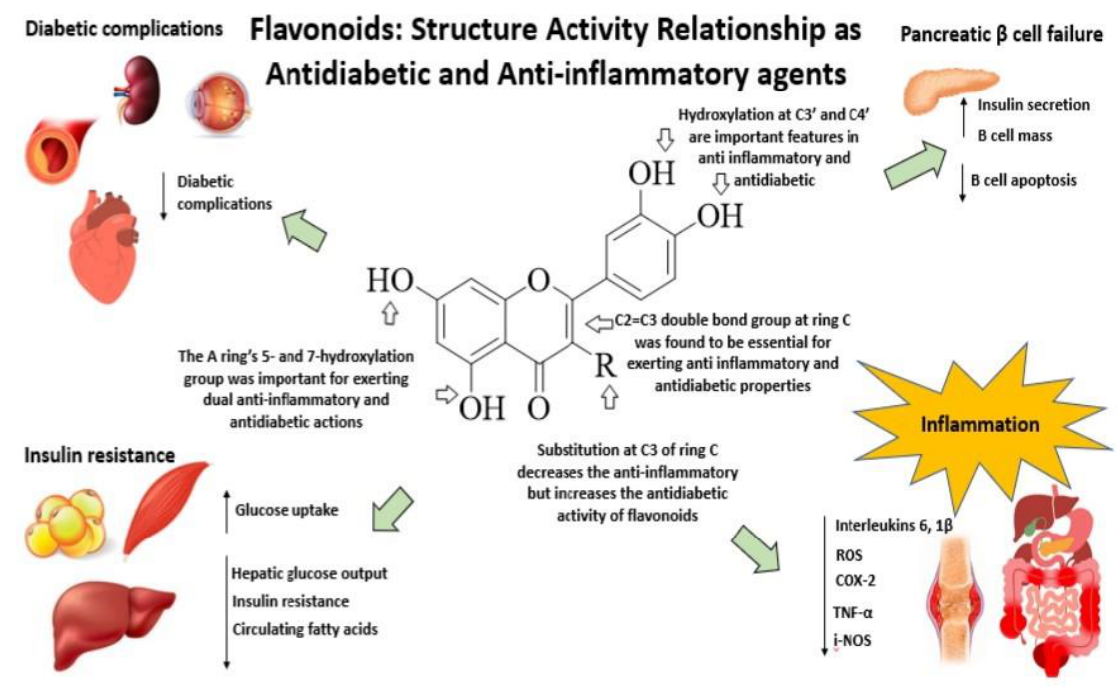
Figure 31. The SAR of flavonoids as dual action via anti-inflammatory and antidiabetic effects. Flavonoids have been reported to reduce diabetes complications, improve insulin secretion and pancreatic β cell mass, reduce β cell apoptosis, hepatic glucose output, insulin resistance , and circulating fatty acids, and downregulate ROS and inflammation markers such as IL- β and IL -6, Tnf- α, COX -2, and i-NOS. Table 2. Important structural characteristics of different classes of flavonoids as anti-inflammatory and antidiabetic activities. The up arrow means increasement and the down arrow means decrease- ment of the activity.